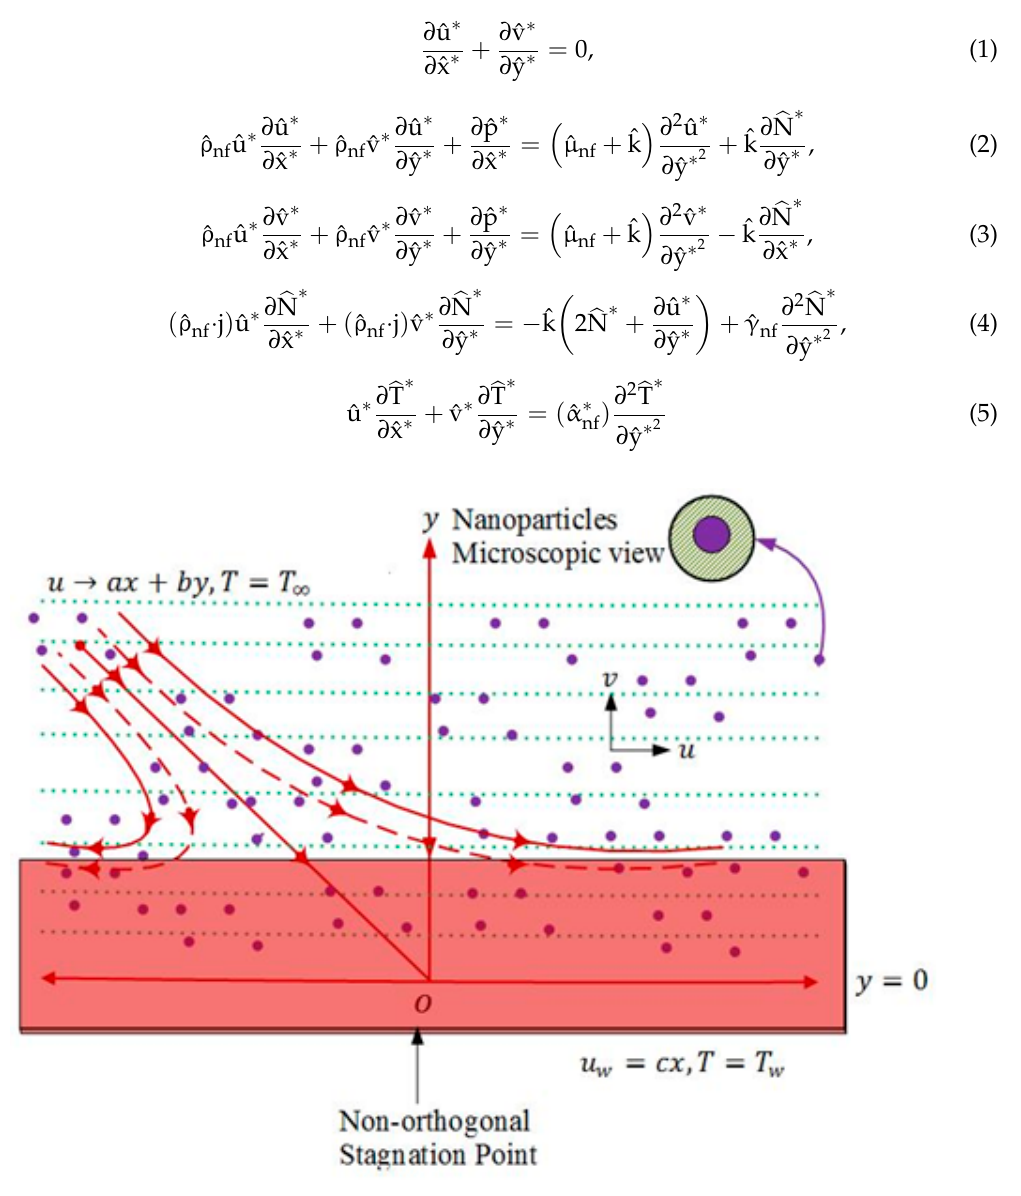
Figure 1. Physical depiction of flow problem.